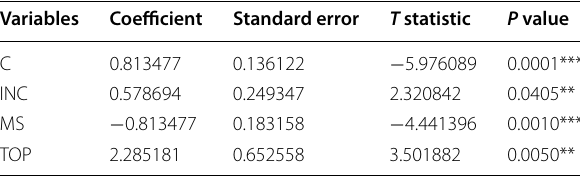
Source Computed using Microfit